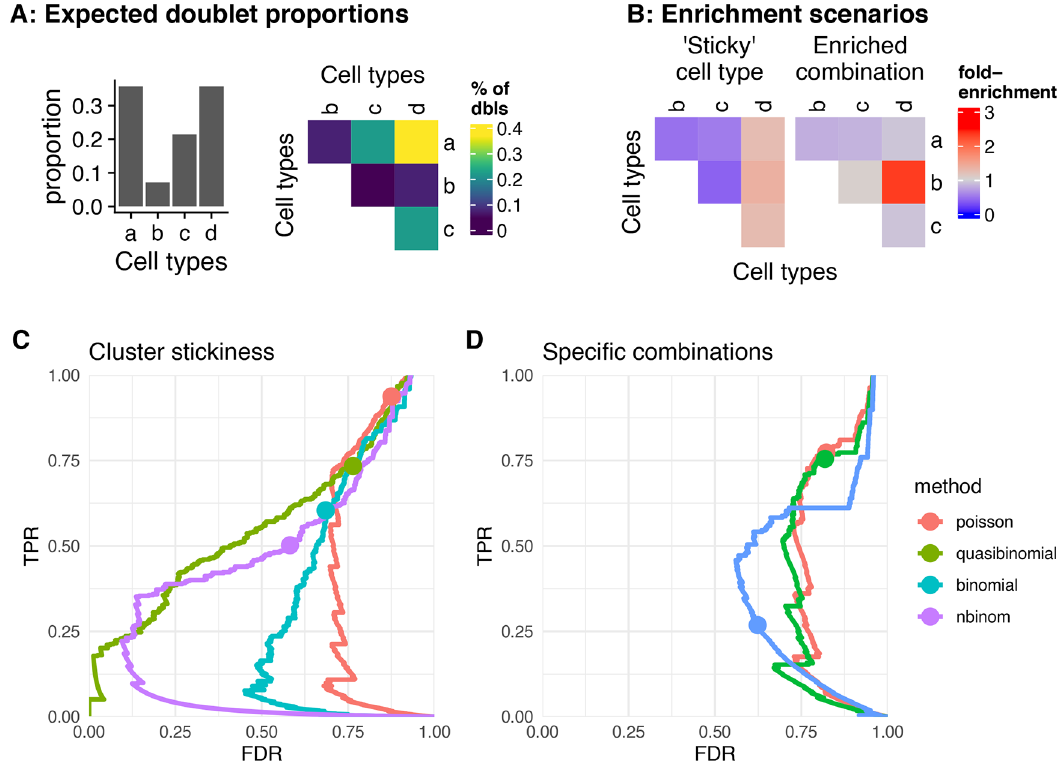
Figure 8. Doublet enrichment analysis. A, B: Doublet enrichment in a toy example. A: Proportion of different doublet types from random expectations based on the cell type abundances. B: The fold-enrichment over this expectation in two different doublet enrichment scenarios. C, D: Performance of the cluster stickiness tests (C) and tests for enrichment of specific combinations (D) using different underlying